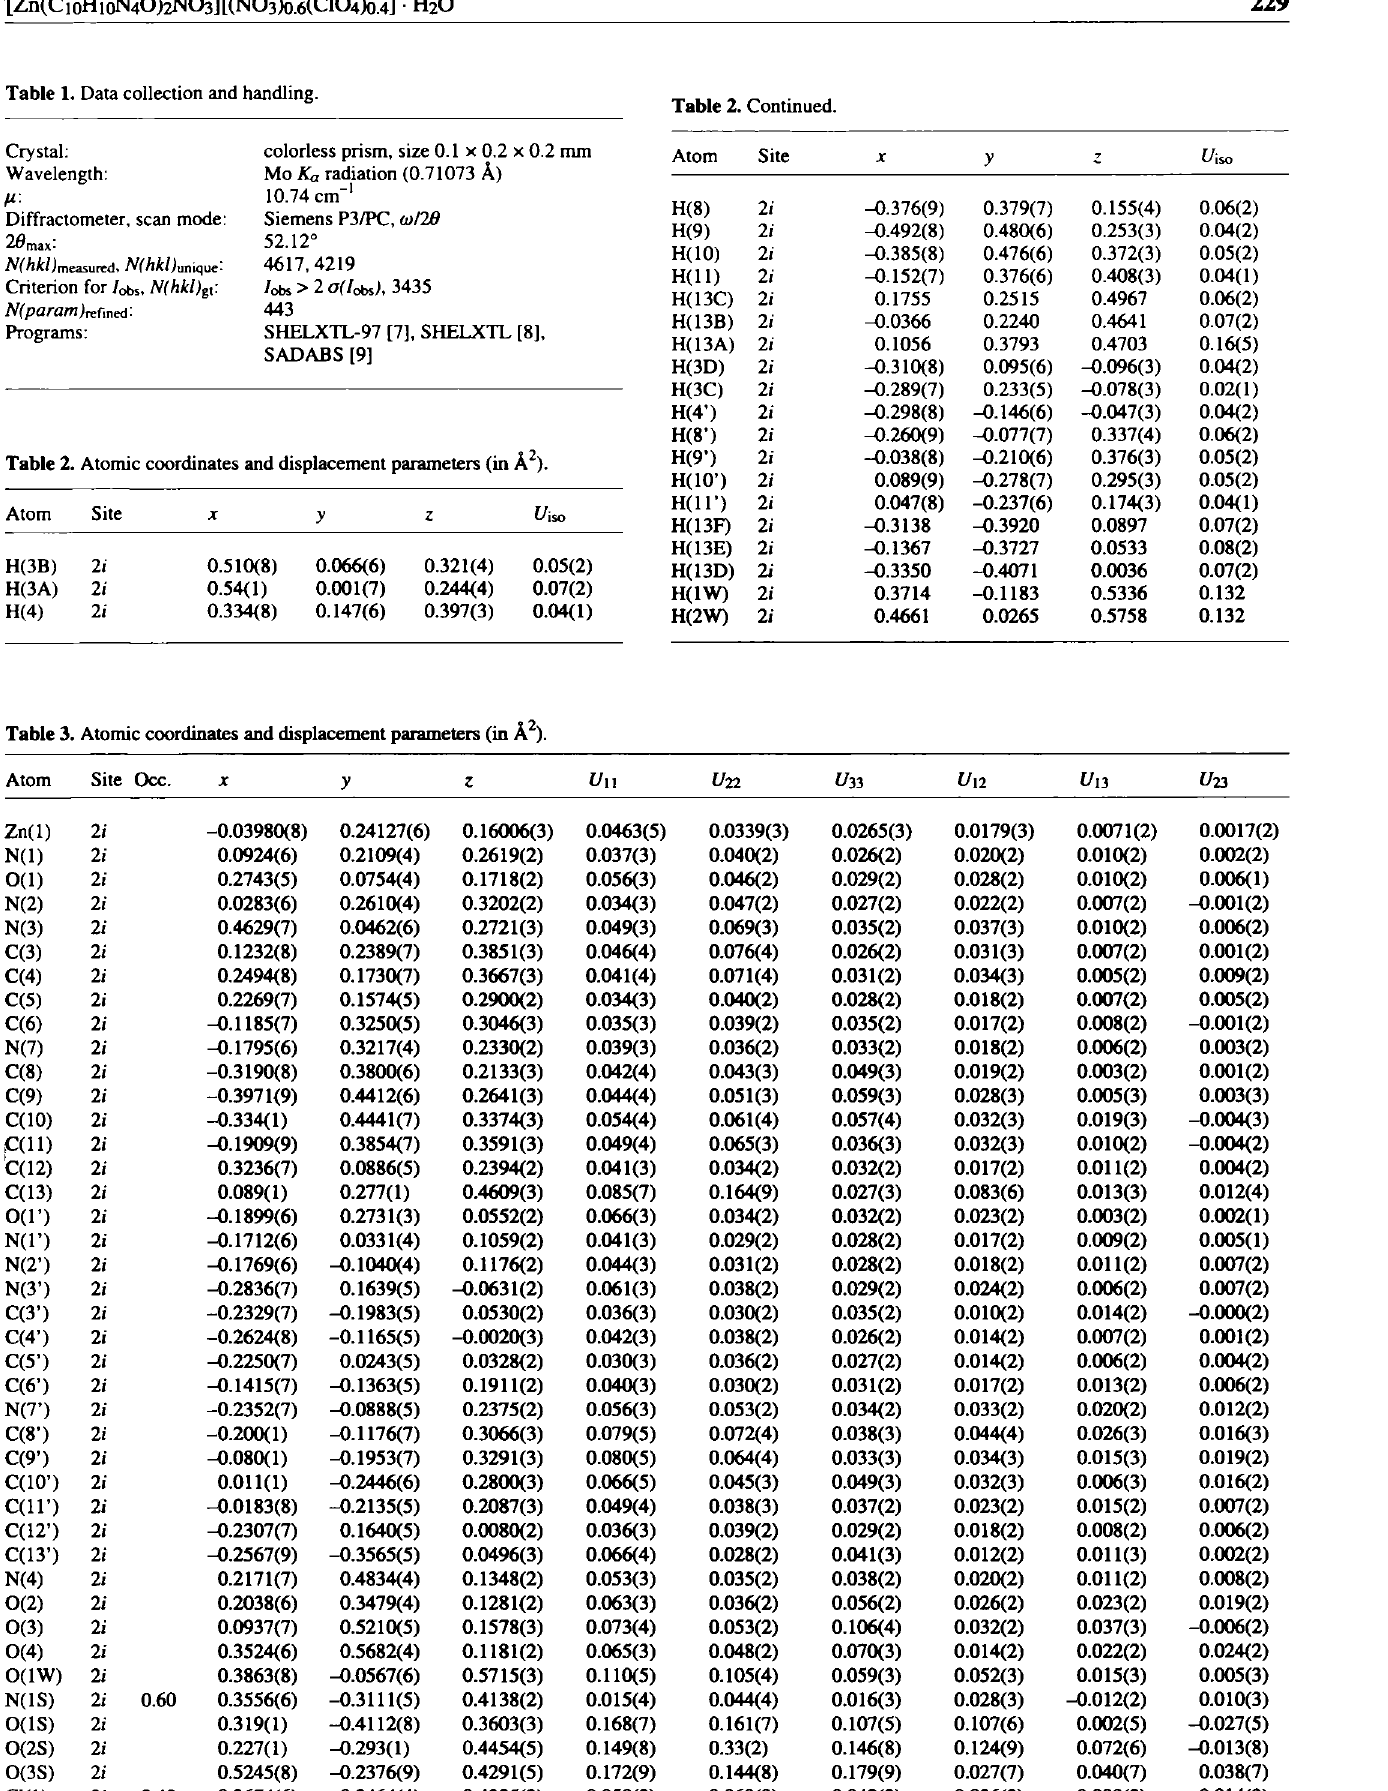
Table 1. Data collection and handling.